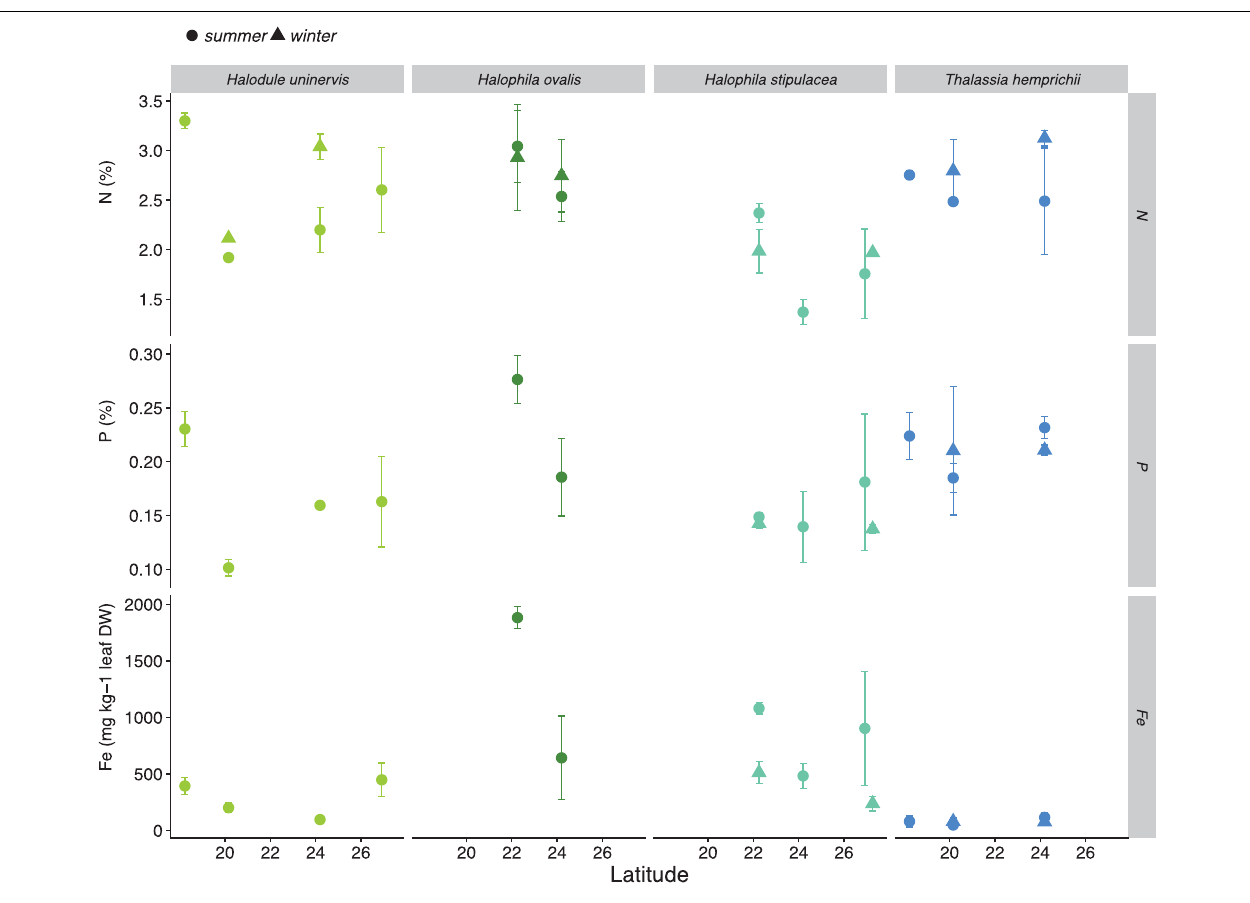
FIGURE 5 | Nutrient concentration (%N, %P, and [Fe] in mg kg − 1 DW) in the leaves of five species of seagrasses across the Red Sea. Colors indicate the dominant seagrass species on the meadows ( Halodule uninervis in light green, Halophila ovalis in dark green, Halophila stipulacea in light blue, and Thalassia hemprichii in indigo blue). Solid dots and triangles indicate the mean ± SD per location in the summer and winter of 2017, respectively. Statistical results provided on Supplementary Table S5